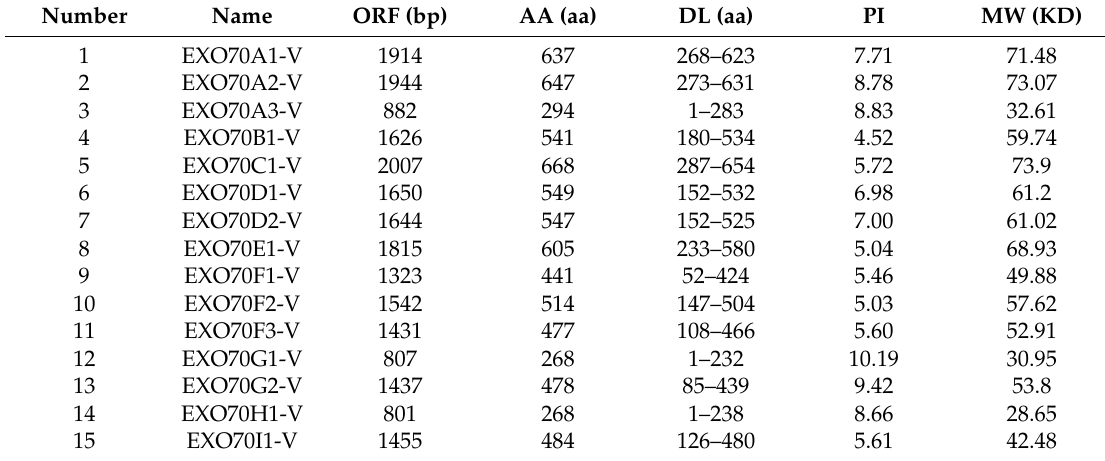
Table 1. EXO70 genes cloned from H. villosa .